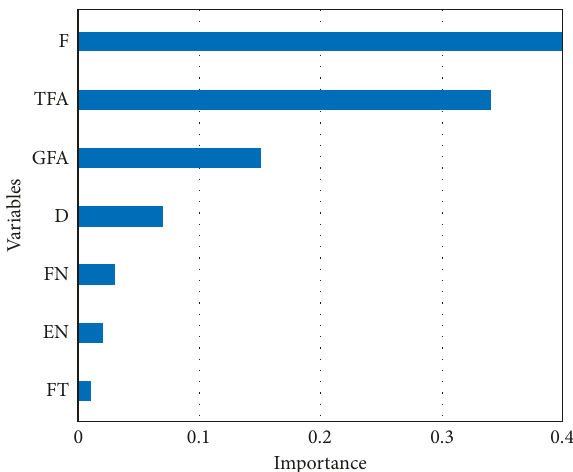
Figure 5: Feature selection of the XGBoost Table 3: Performance measures of AI models for training data.